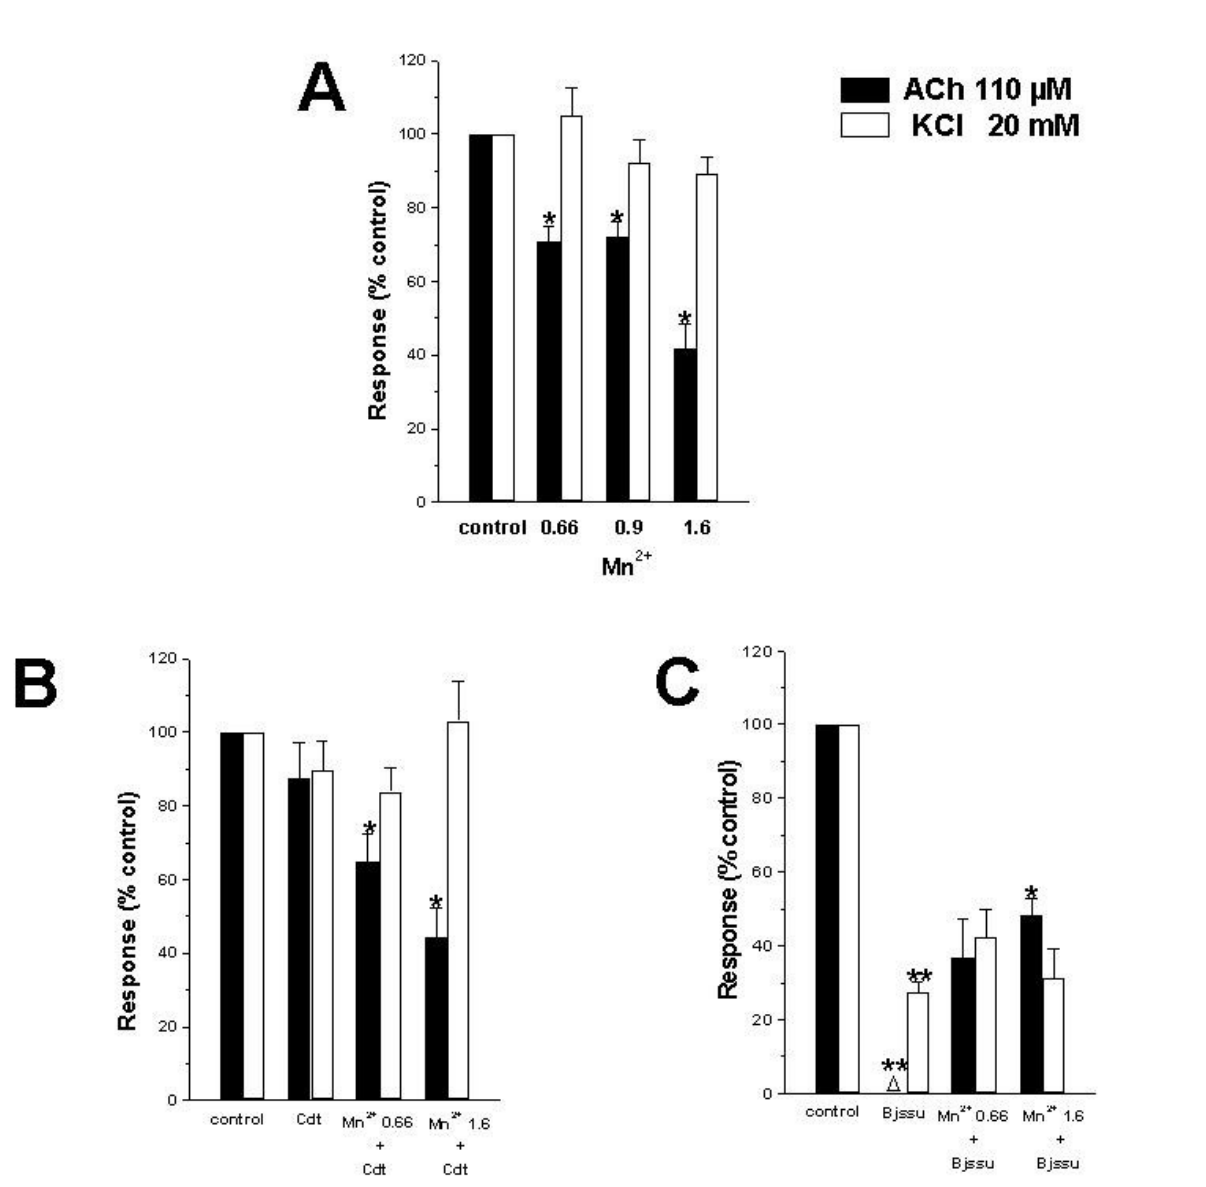
Figure 2. Effects of Mn 2+ , Crotalus durissus terrificus (Cdt) and Bothrops jararacussu (Bjssu) venoms – Contracture responses to ACh and KCl. (A) Concentration-inhibition curve of Mn 2+ ions. ( B ) Effect of 10 μ g/ml Cdt venom alone and after pretreatment with Mn 2+ (0.66 and 1.6mM). Note that Mn 2+ pretreatment reduced the response to ACh, differently from treatment with venom alone. ( C ) Effect of 200 μ g/ml Bjssu venom alone and after pretreatment with Mn 2+ (0.66 and 1.6mM). Note that the response to the ACh was triggered by the Mn 2+ action. ∆ indicates that the venom sample totally blocked the response to the agonist (ACh). Each point represents the mean ± S.E.M of 5–9 experiments. *p<0.05, compared with control ( A ) and with Bjssu ( B ) and Cdt ( C ) venoms alone; **p<0.05, compared with control ( C